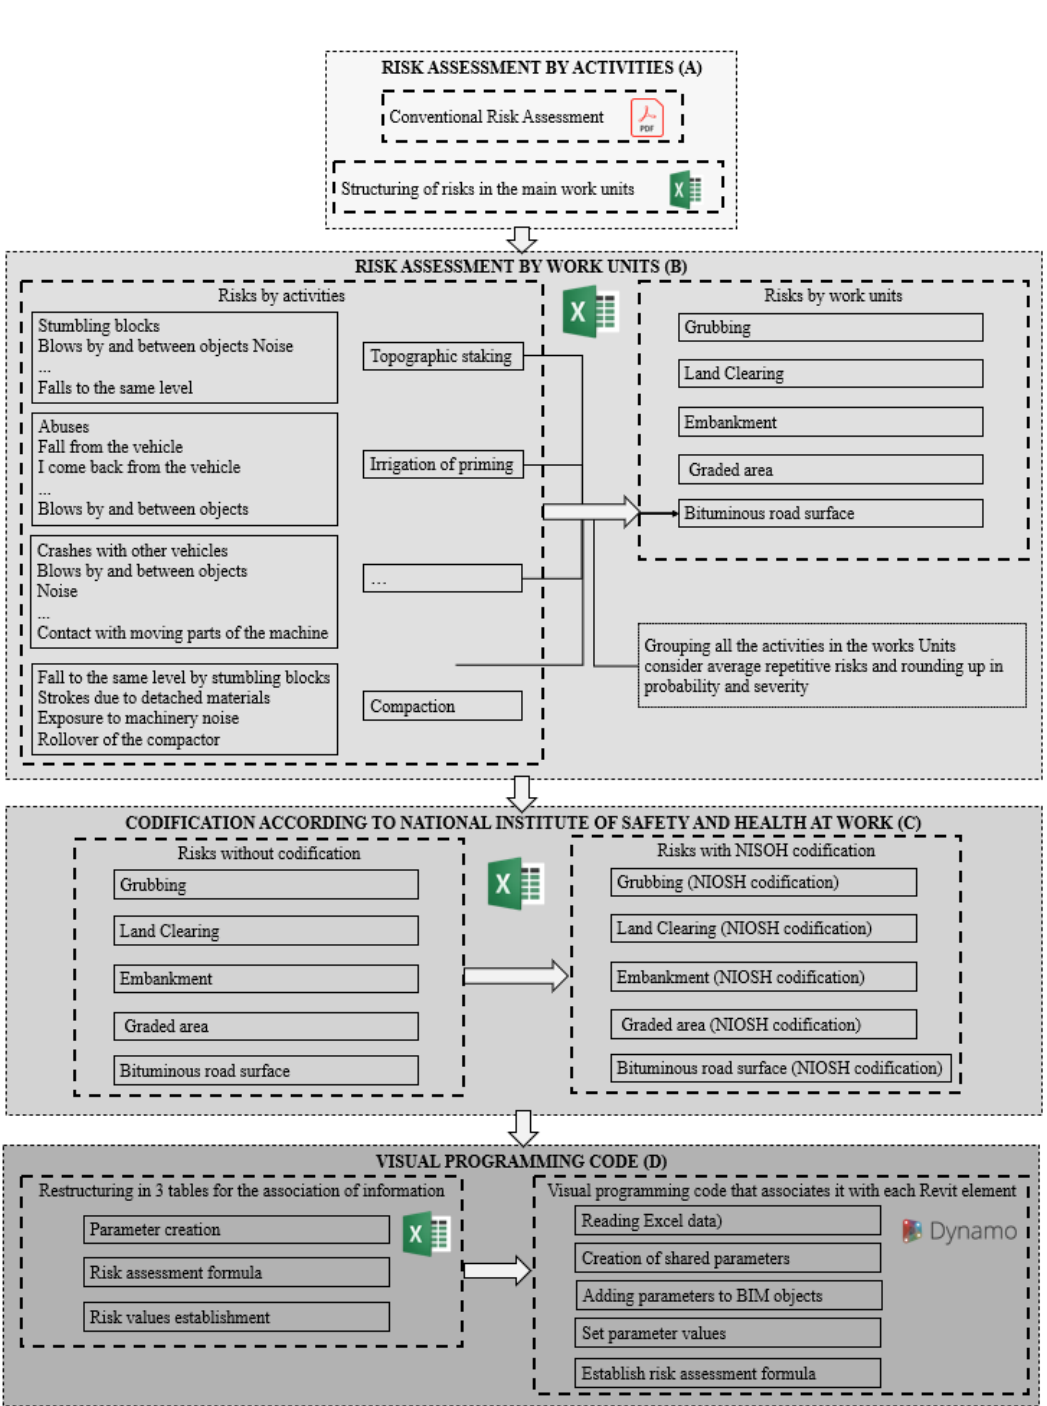
Figure 2. Workflow to link the risk assessment results to the BIM objects (( A ) Risk assessment information by activities, ( B ) Risks assessed by activity are then assessed for each work unit, ( C ) These risks are coded according to the National Institute for Occupational Safety and Health, ( D ) The risk assessment information is structured in Excel and entered with Dynamo 2.3 to each of the elements in Revit 2020. The background color is not relevant.